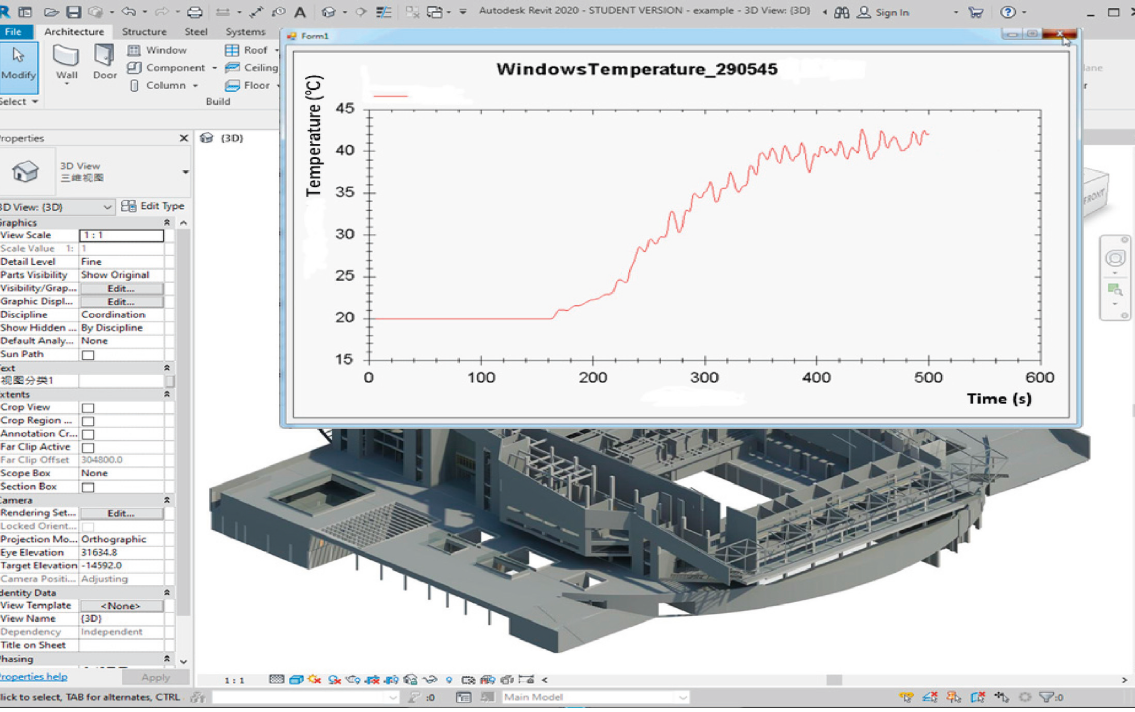
Figure 20: Data and diagrams of temperature change near a